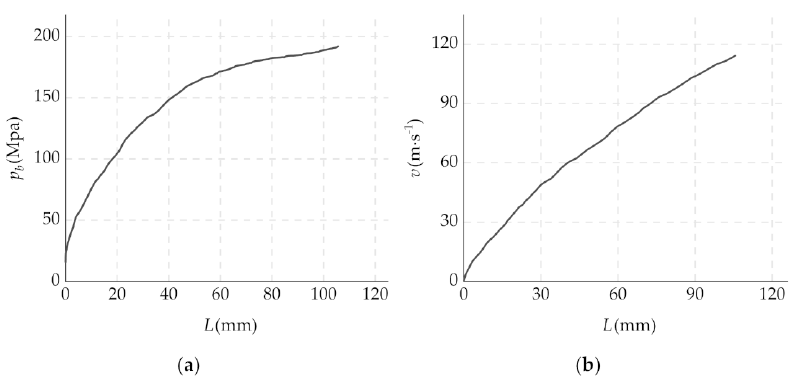
Figure 6. ( a ) Pressure at the projectile base vs. projectile displacement; ( b ) projectile velocity vs. projectile